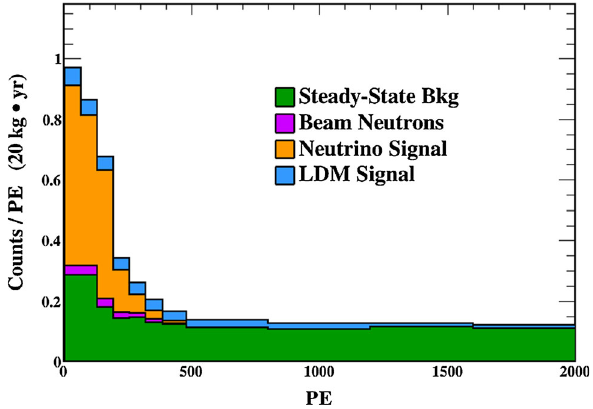
Fig. 16 Energy spectra of the proposed detector at the SNS in the prompted neutrino window (0 ∼ 6 μ s) with an exposure of 20 kg · year